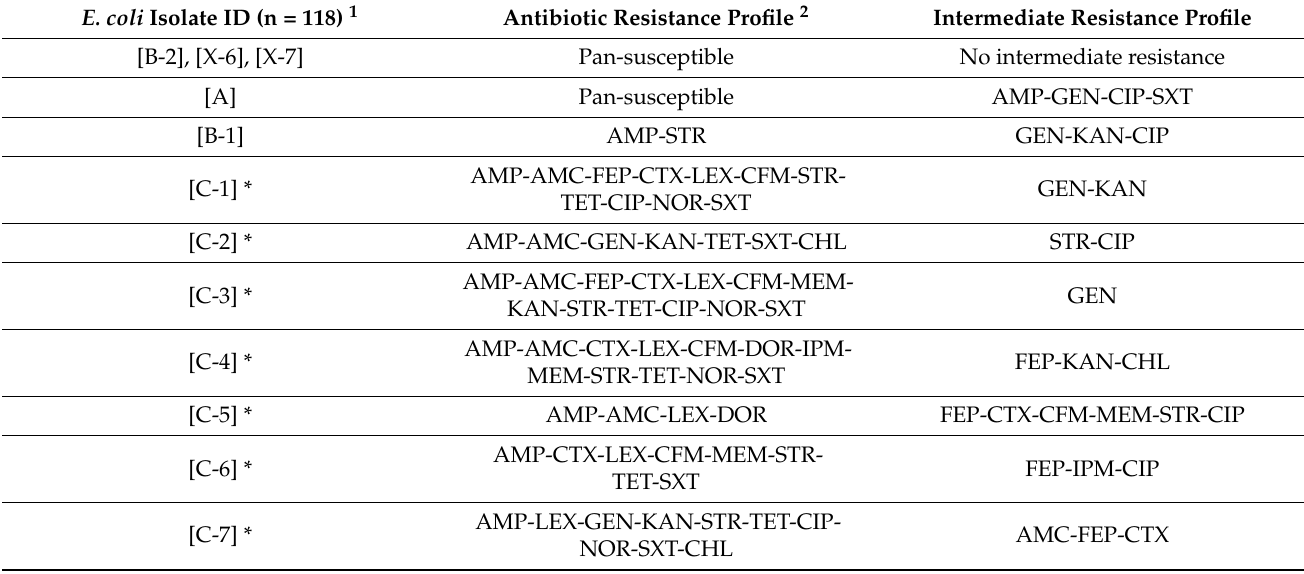
Table 1. Antibiotic Resistance Profiles of 118 E. coli isolated from Akkawi cheese collected from Retail Stores in Beirut,